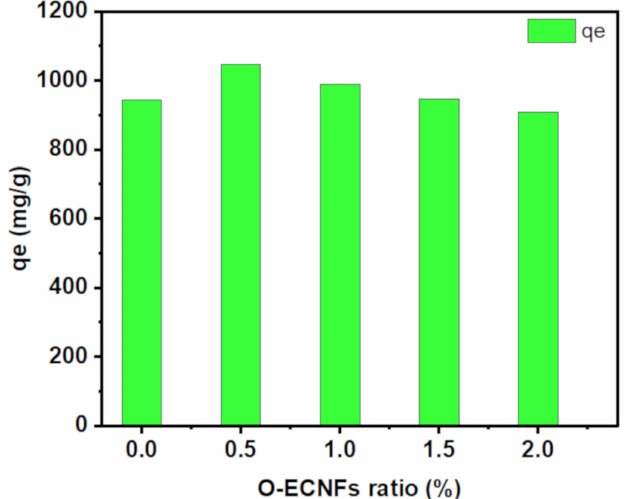
Figure 7. E ff ect of O-ECNFs amount on the adsorption capability of CT- g -PAA / O-ECNFs hydrogel